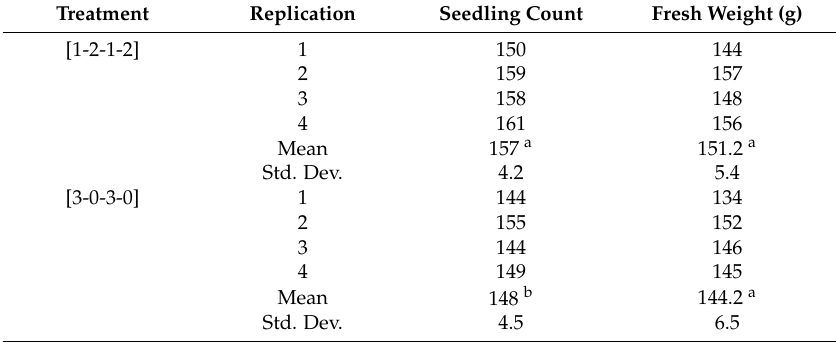
Table 3. Effects of seeding pattern on seed germination from 195 seeds per replicate block and harvested fresh weight yield of Carmel spinach. Cells were seeded according in [1-2-1-2] or [3-0-3-0] patterns giving average density of 1.5 seeds per cell. Different superscripts indicate significant differences between treatments by Tukey–Kramer paired t -tests at α =